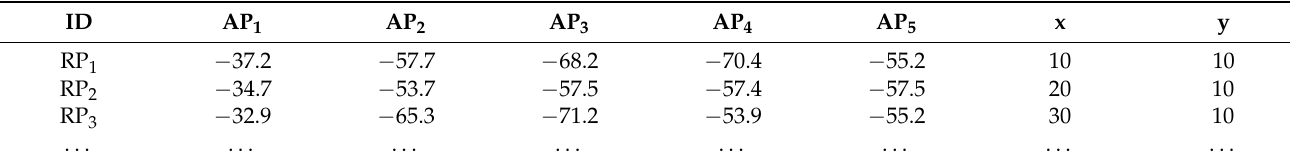
Table 1. Composition of the fingerprint database.